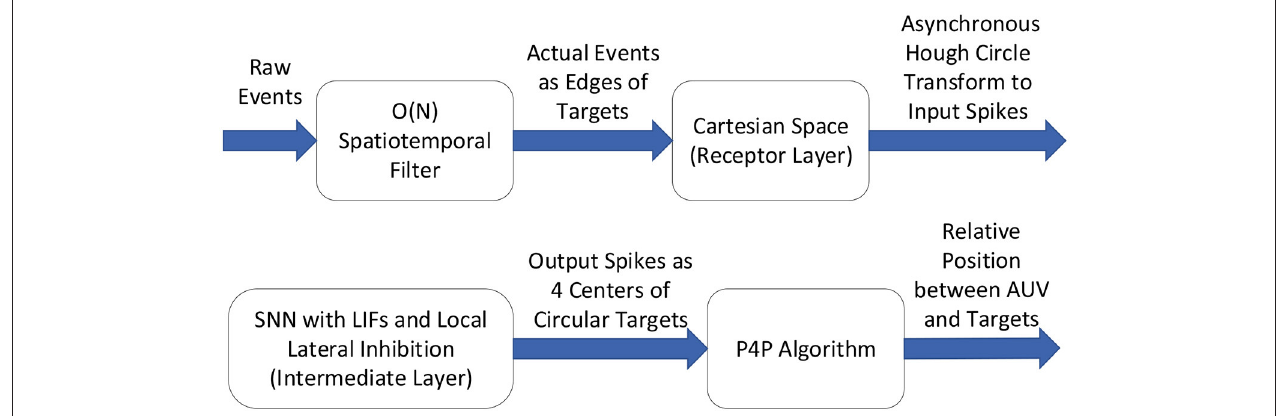
FIGURE 2 | Overview of the detection